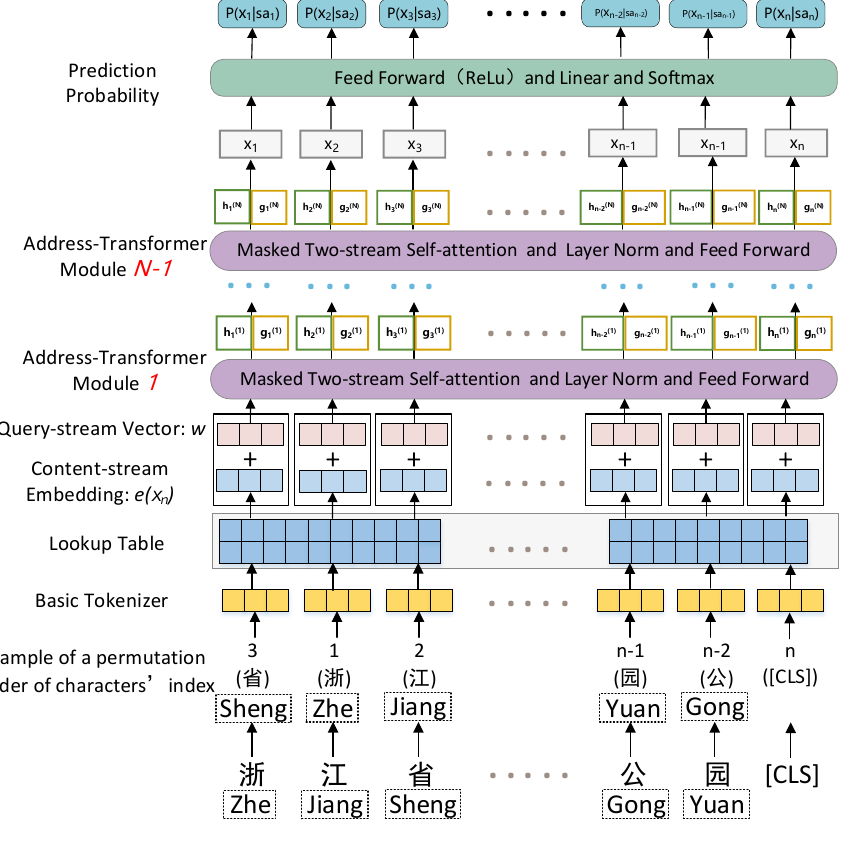
Figure 1. The overall structure of the ASM.